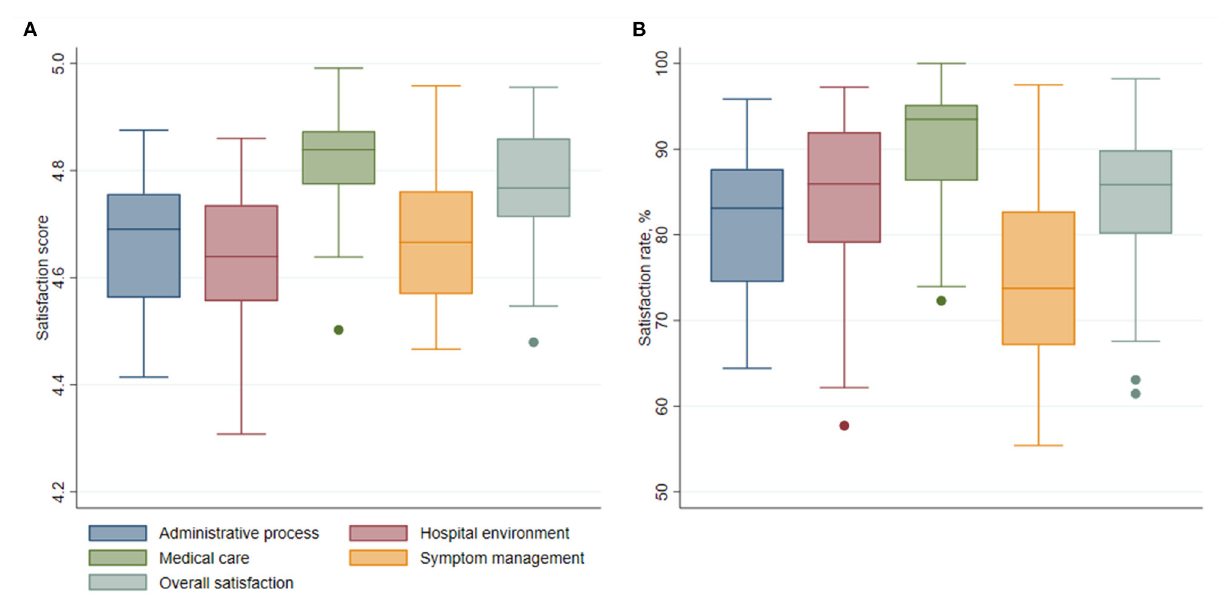
with the four aspects, except for the medical care aspect. When representatives completed the questionnaire, satisfaction rates with the administrative process, hospital environment, and symptom management were ∼ 18–24% lower than when patients completed the survey (Table